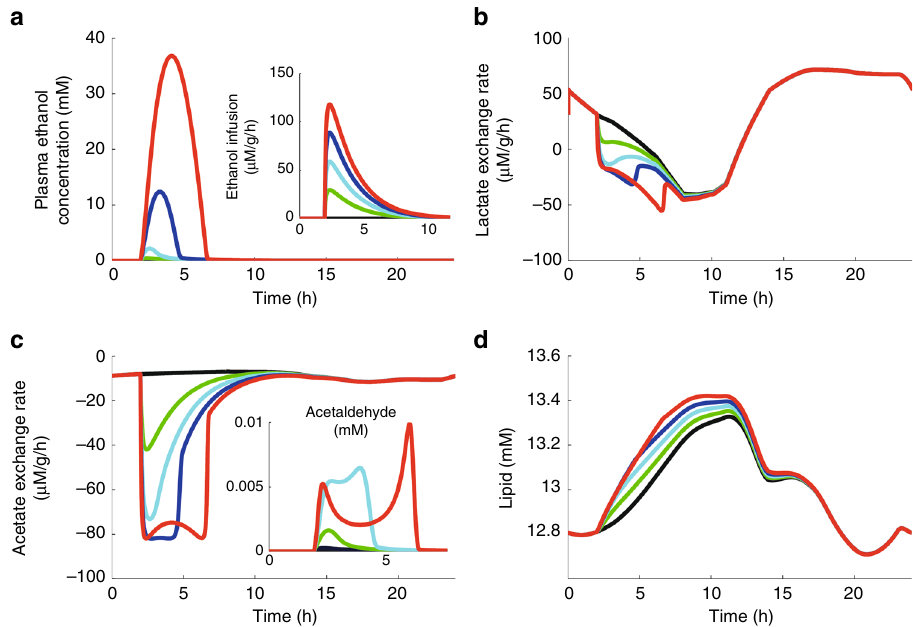
Fig. 6 Response of liver metabolism to an alcohol challenge. a Plasma pro fi le of ethanol at three different alcohol infusion pro fi les depicted in the small insertion. b Lactate exchange fl ux. c Acetate exchange fl ux. The pro fi le of the toxic intermediate acetaldehyde is depicted in the small insertion. Note that the inhibition of the alcohol dehydrogenase at high ethanol concentrations accounts for the delayed steep rise of acetaldehyde if ethanol has already dropped to low level. d Triglyceride content. Whereas the plasma level of ethanol was normalized at times 5 – 7 h, the cellular increase of triglyceride persisted about 4 h up to time point T = 11